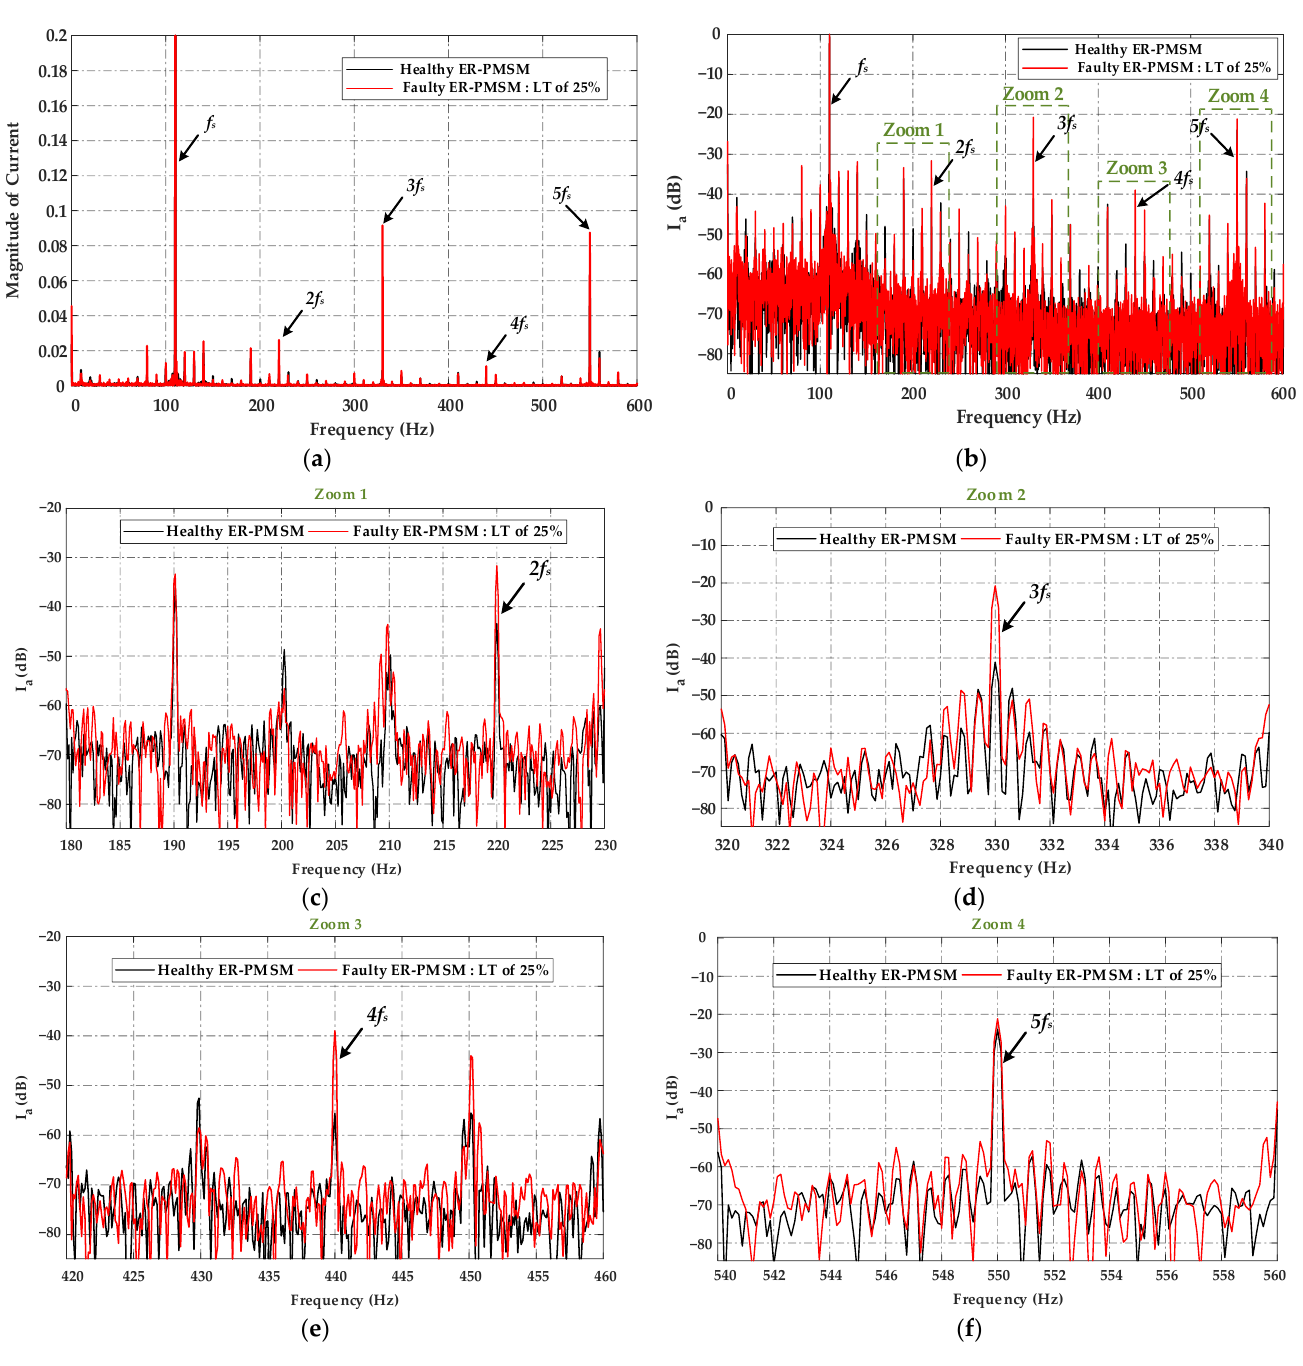
Figure 20. ( a – f ) Experimental current spectrum of the ER-PMSM at 8 Nm load and 600 rpm, in healthy and faulty conditions with an LTs fault of 25%. healthy and faulty conditions with an LTs fault of Table 3. Experimental magnitude of current components generated by the ER-PMSM at 8 Nm load and f s = 110 Hz.